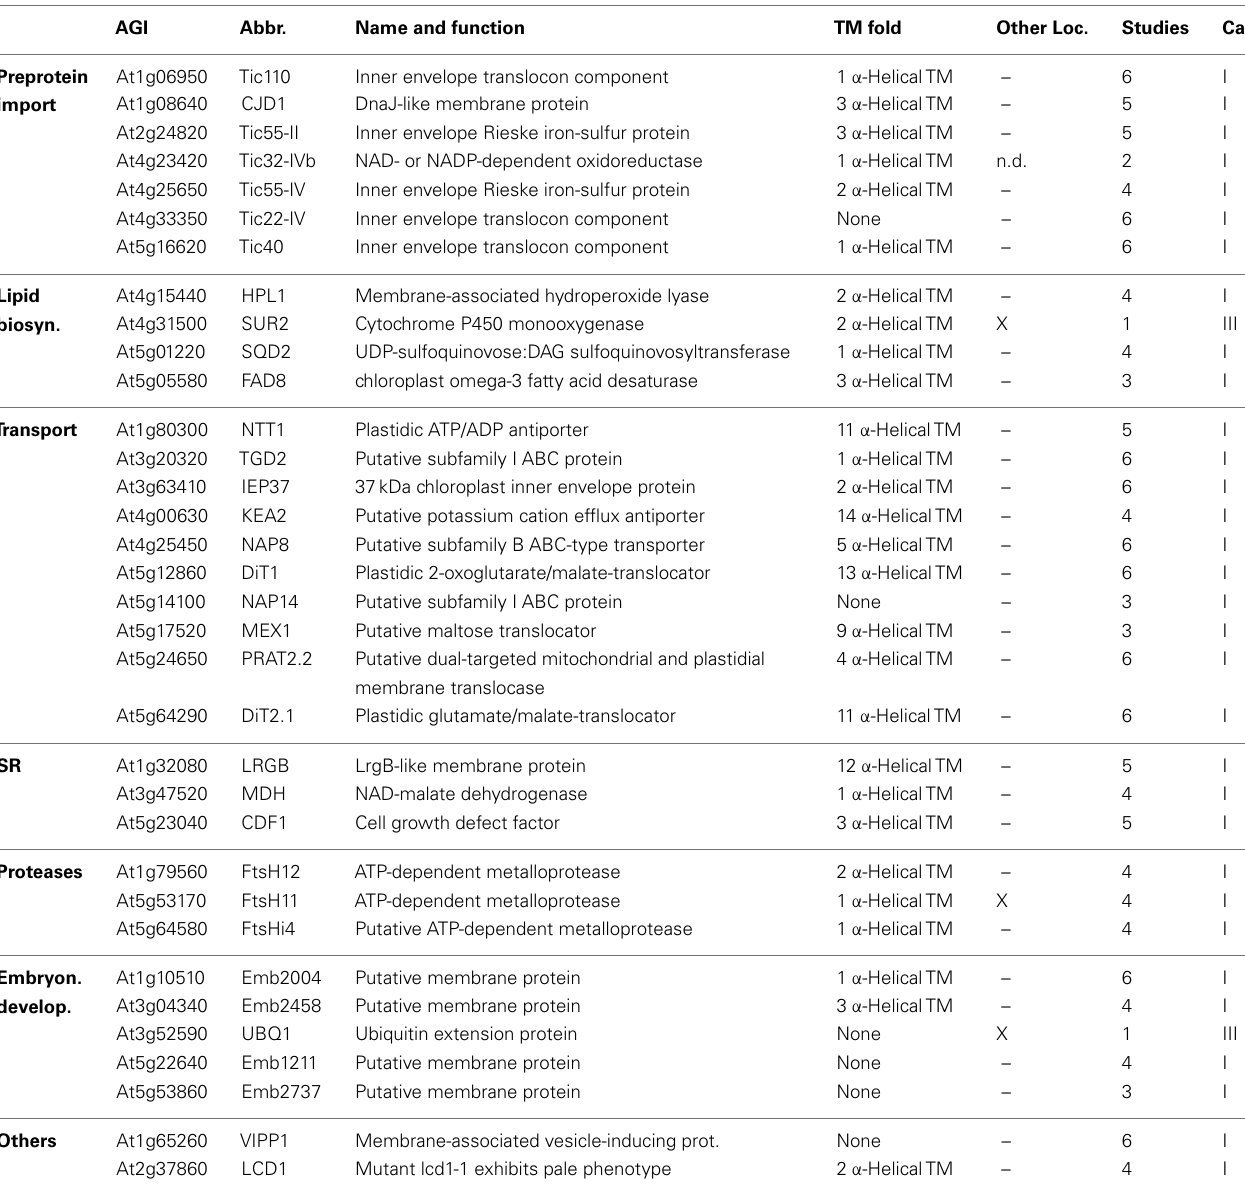
Table 4 | Inner envelope proteins with known